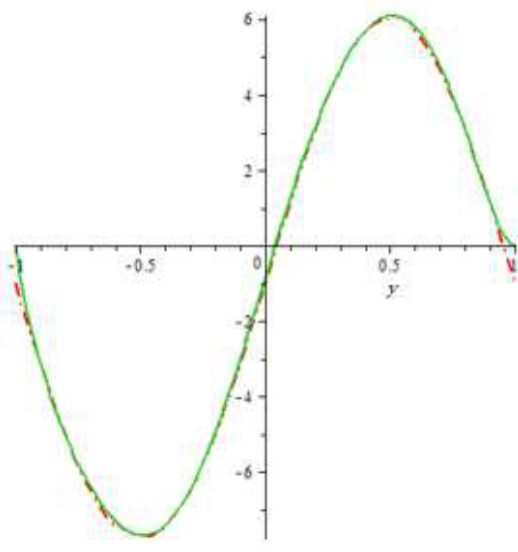
Fig. 4 Approximation to the Source function in terms of the base Function at t=1 for (N=8), Green line is the source function and red line(dotted line) approximation.